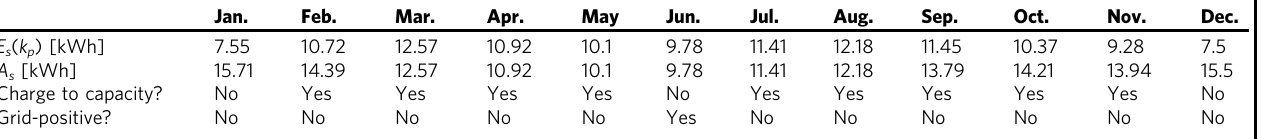
Table 2 Monthly simulation results for Los Angeles,